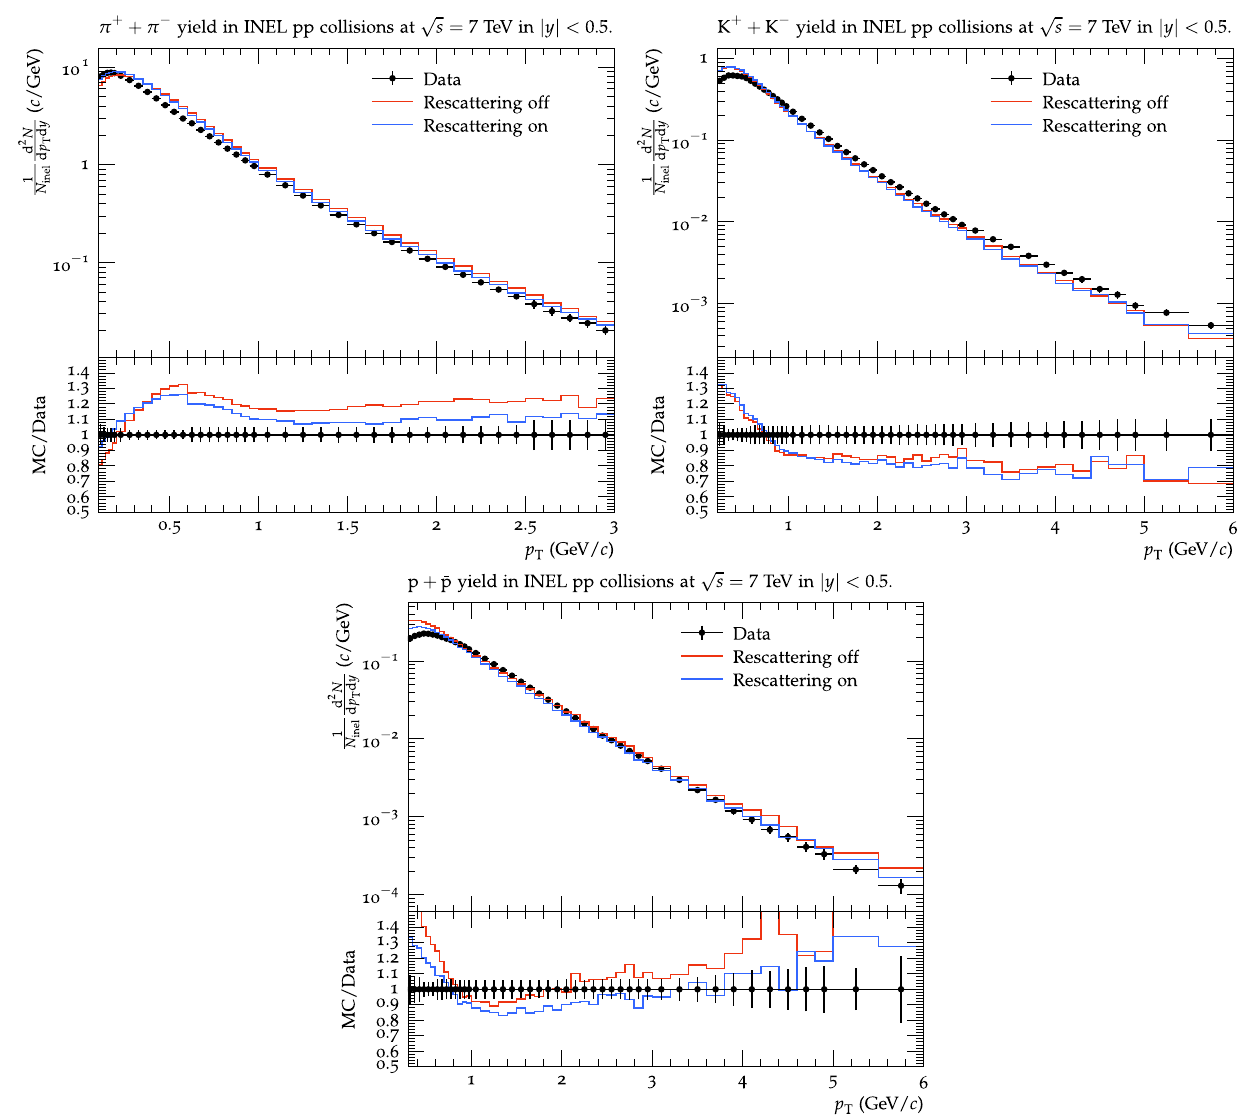
Fig. 15 p ⊥ spectra for π ± , K ± and p / p, compared with data from ALICE